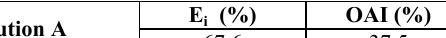
Table 6. Indicators (OAI) and (E i ) of solution A Solution A